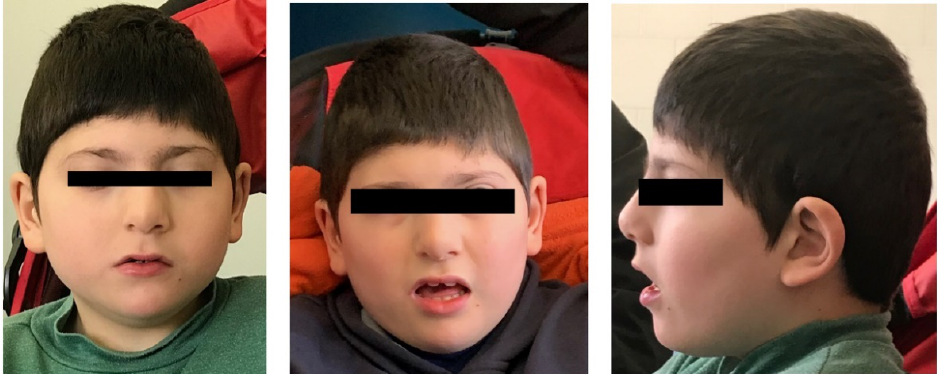
Figure 1. Craniofacial features observed in the investigated subject.